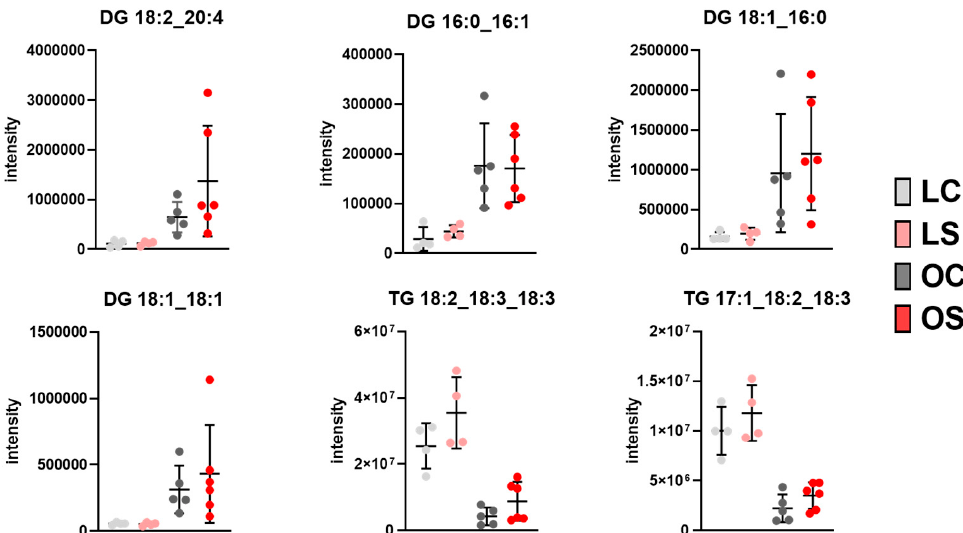
Figure 7. Intensity boxplot of lipids identified by the lipidomics approach in epididymal adipose tissue with differences in diet ( p < 0.05). LC, lean control; LS, lean supplemented with sofrito; OC, obese control; OS, obese supplemented with sofrito .